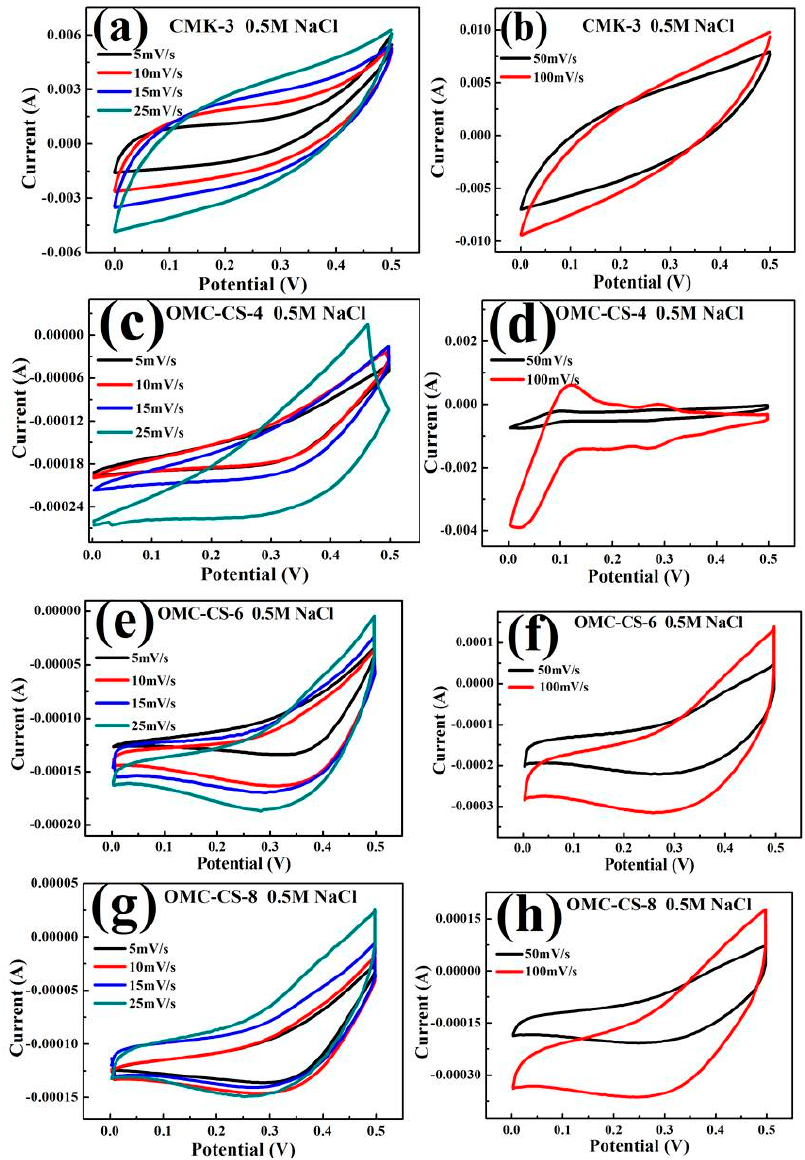
Figure 7. ( a , b ) Cyclic voltammograms of CMK-3; ( c , d ) Cyclic voltammograms of OMC-CS-4; ( e , f ) Cyclic voltammograms of OMC-CS-6; ( g , h ) Cyclic voltammograms of OMC-CS-8 at different scan rates.